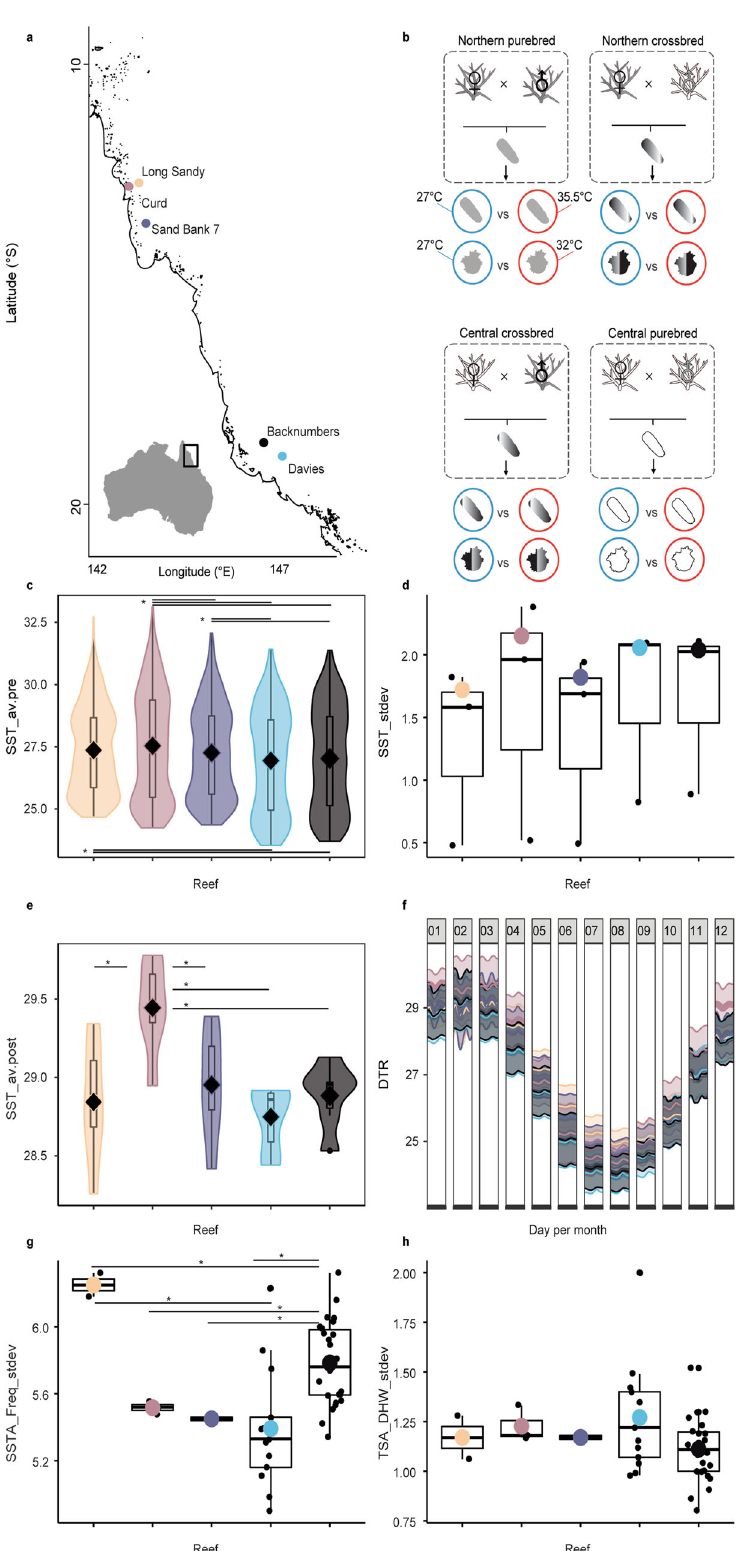
In fl uence of variable symbiont communities on coral heat tolerance . Symbiodiniaceae are taxonomically diverse with many functionally cryptic species 24 . Fitness differences have been attributed to variation in photosynthetic mechanisms and the regulation of speci fi c genes 18 and symbiont community structure and diversity 25 . Juveniles from each cross were exposed to the